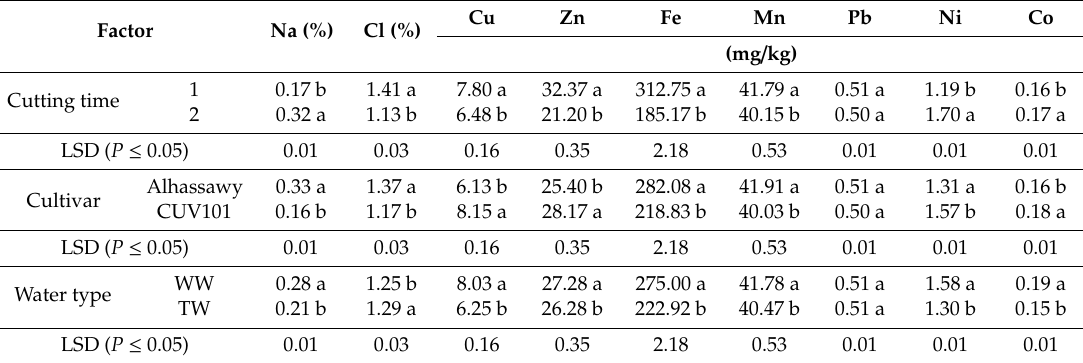
Table 4. Effectsofcuttingtime, cultivar, andwatertypeusedforirrigationonalfalfamicronutrientcontents. Factor Cutting